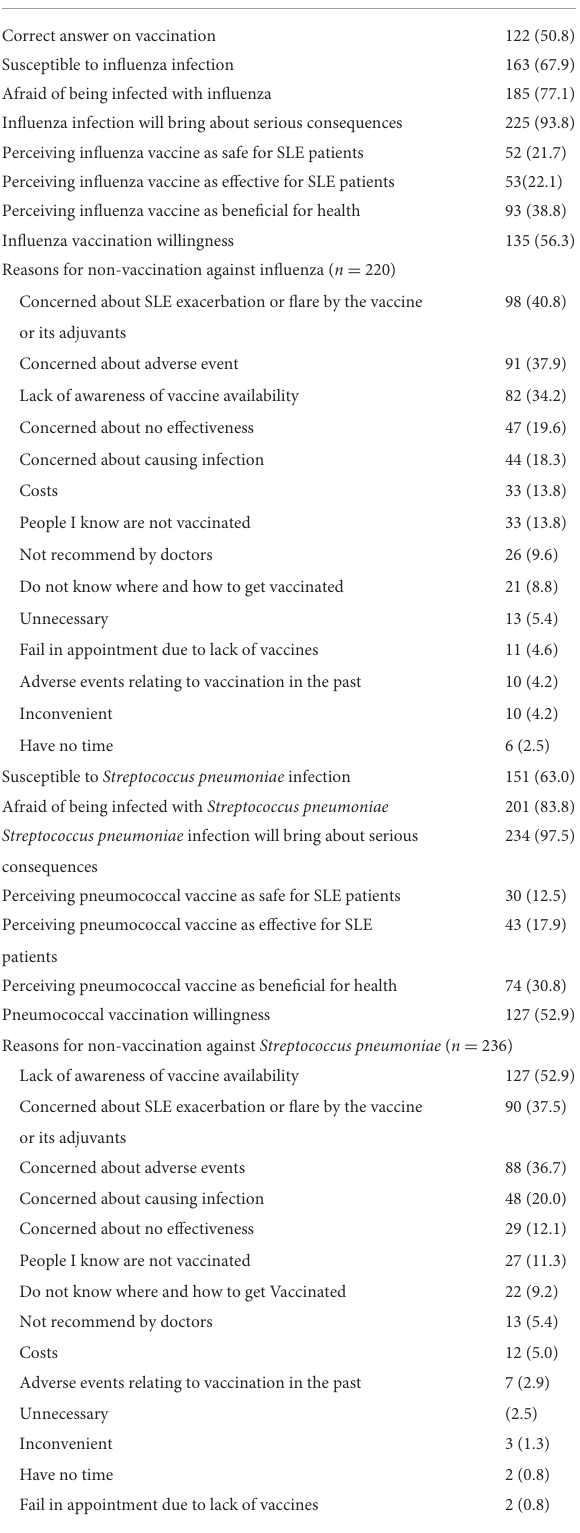
TABLE 3 Knowledge and attitudes regarding infections and vaccines in SLE